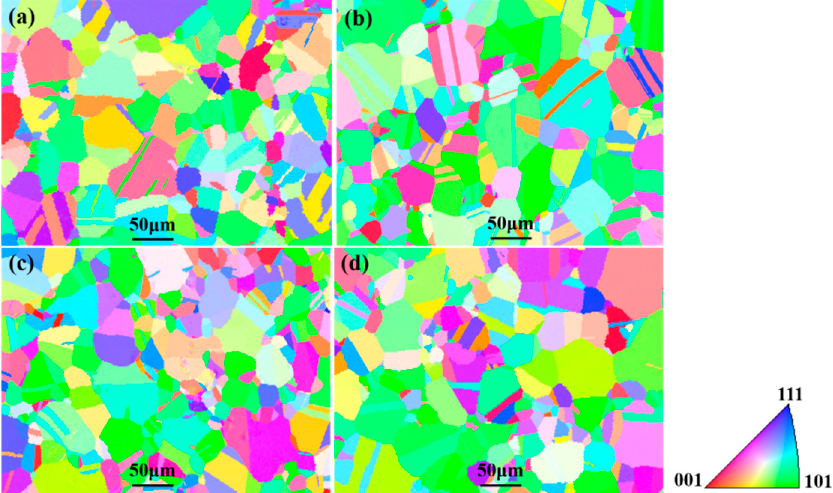
Figure 4. Inverse pole figures (IPFs) of specimens after various heat treatment processes. ( a ) Specimen A; ( b ) specimen B; ( c ) specimen C; ( d ) specimen D.